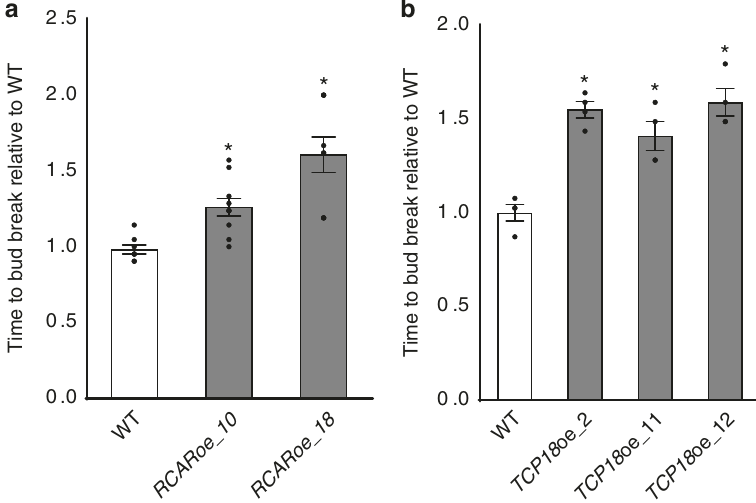
Fig. 6 RCAR/PYL1 or TCP18 / BRC1 overexpression delays bud break in hybrid aspen. Time to bud break relative to WT controls for a RCAR/PYL1 oe and TCP18 / BRC1 oe b plants. Average time taken to bud break ± SEM, with respect to WT considered as 1, is shown with data from 10 plants from each line. Asterisks (*) indicate signi fi cant differences ( P < 0.01), with respect to WT. Statistical analysis was done using t